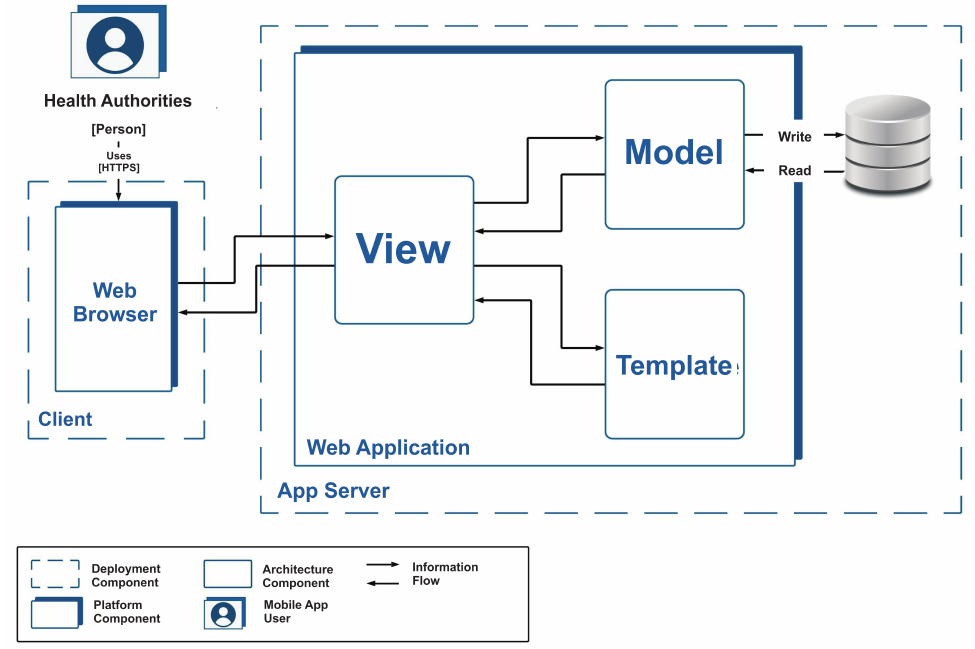
Figure 6. Static and physical view of the web